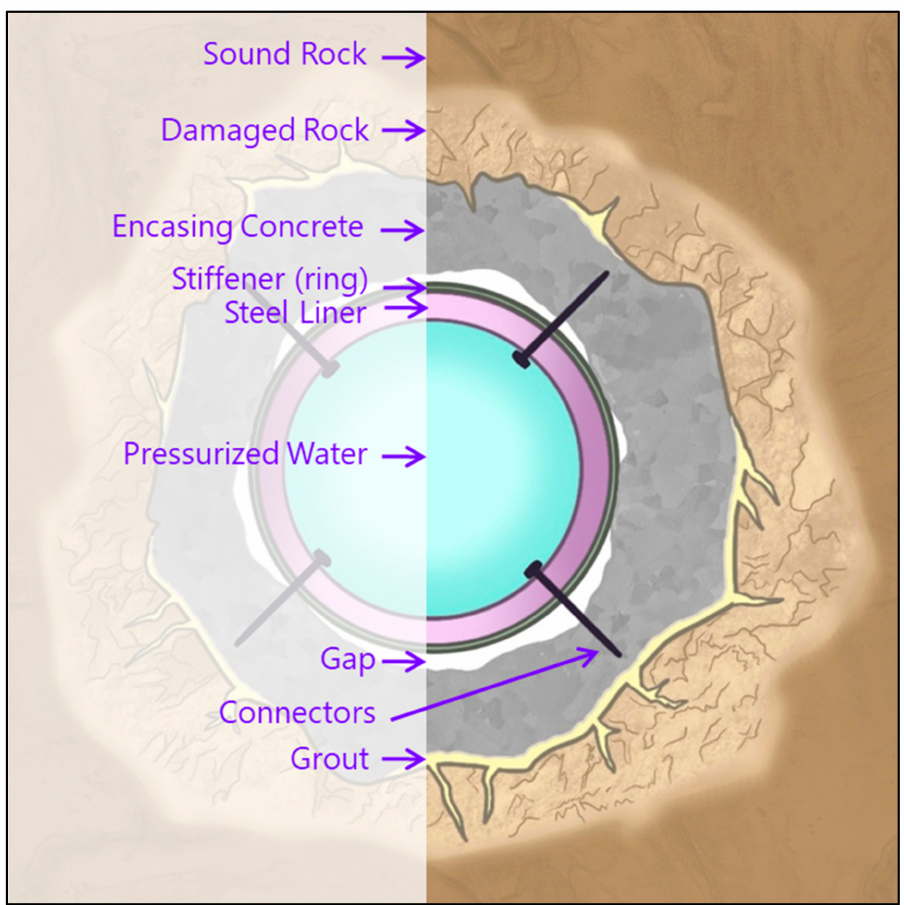
Figure 1. Layout of a pressure tunnel with a steel liner and all